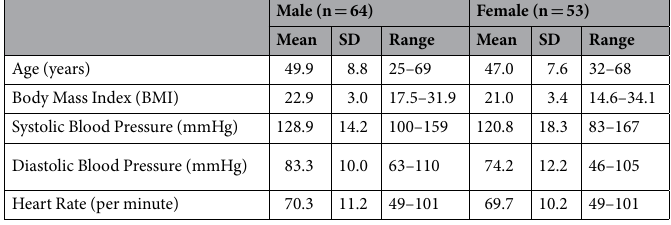
Table 1. Physical characteristics of